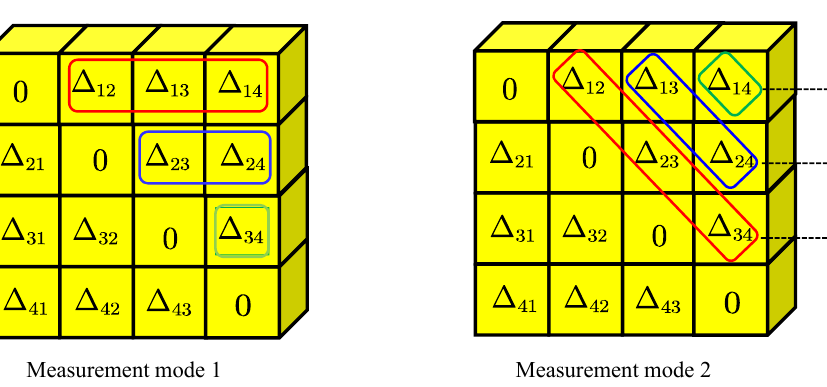
Figure 2. Two different measurement